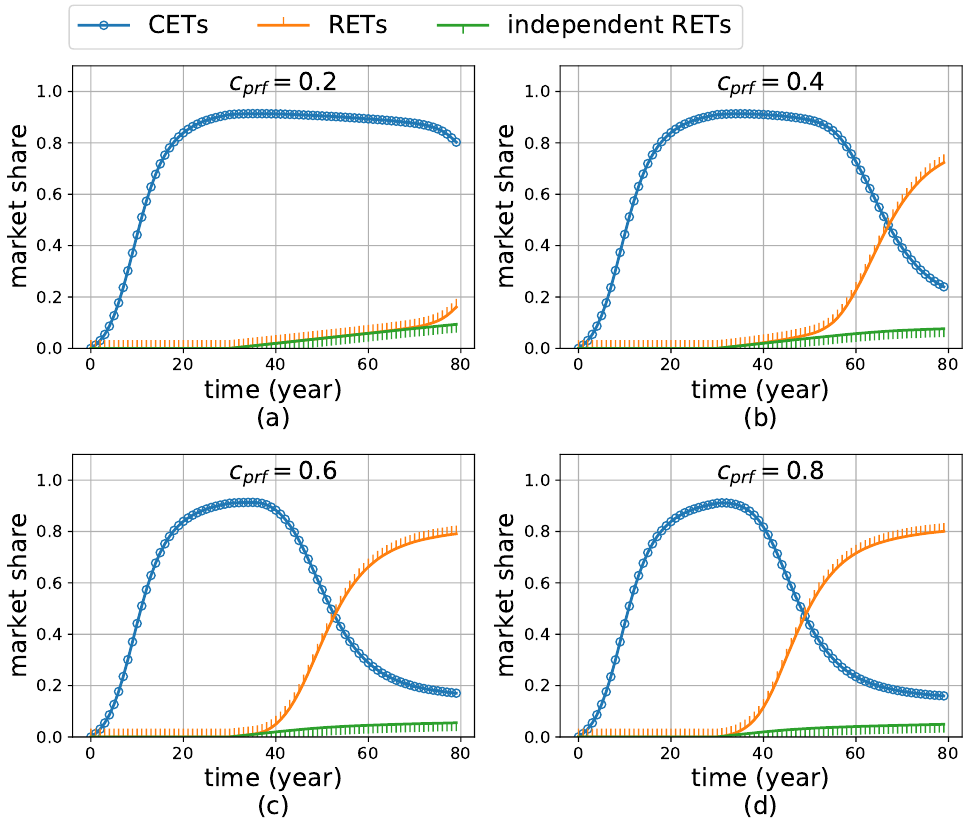
Figure 9. The impact of preference